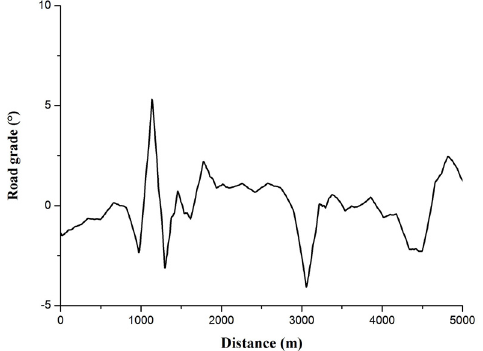
Figure 7. Complex driving cycle (velocity-time).